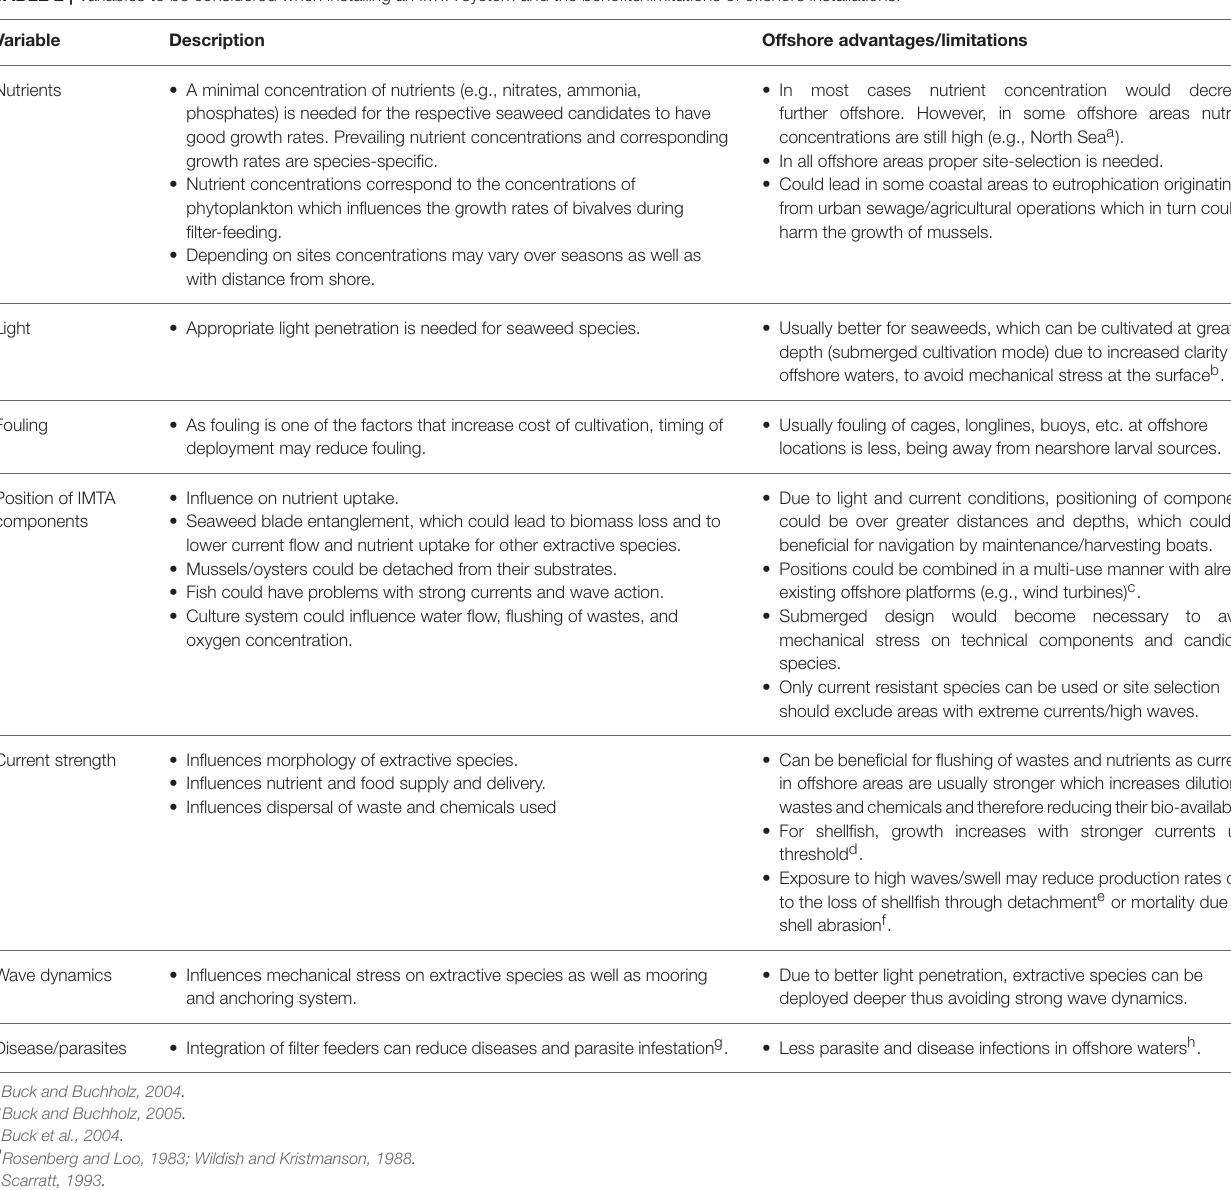
TABLE 2 | Variables to be considered when installing an IMTA system and the benefits/limitations of offshore installations.